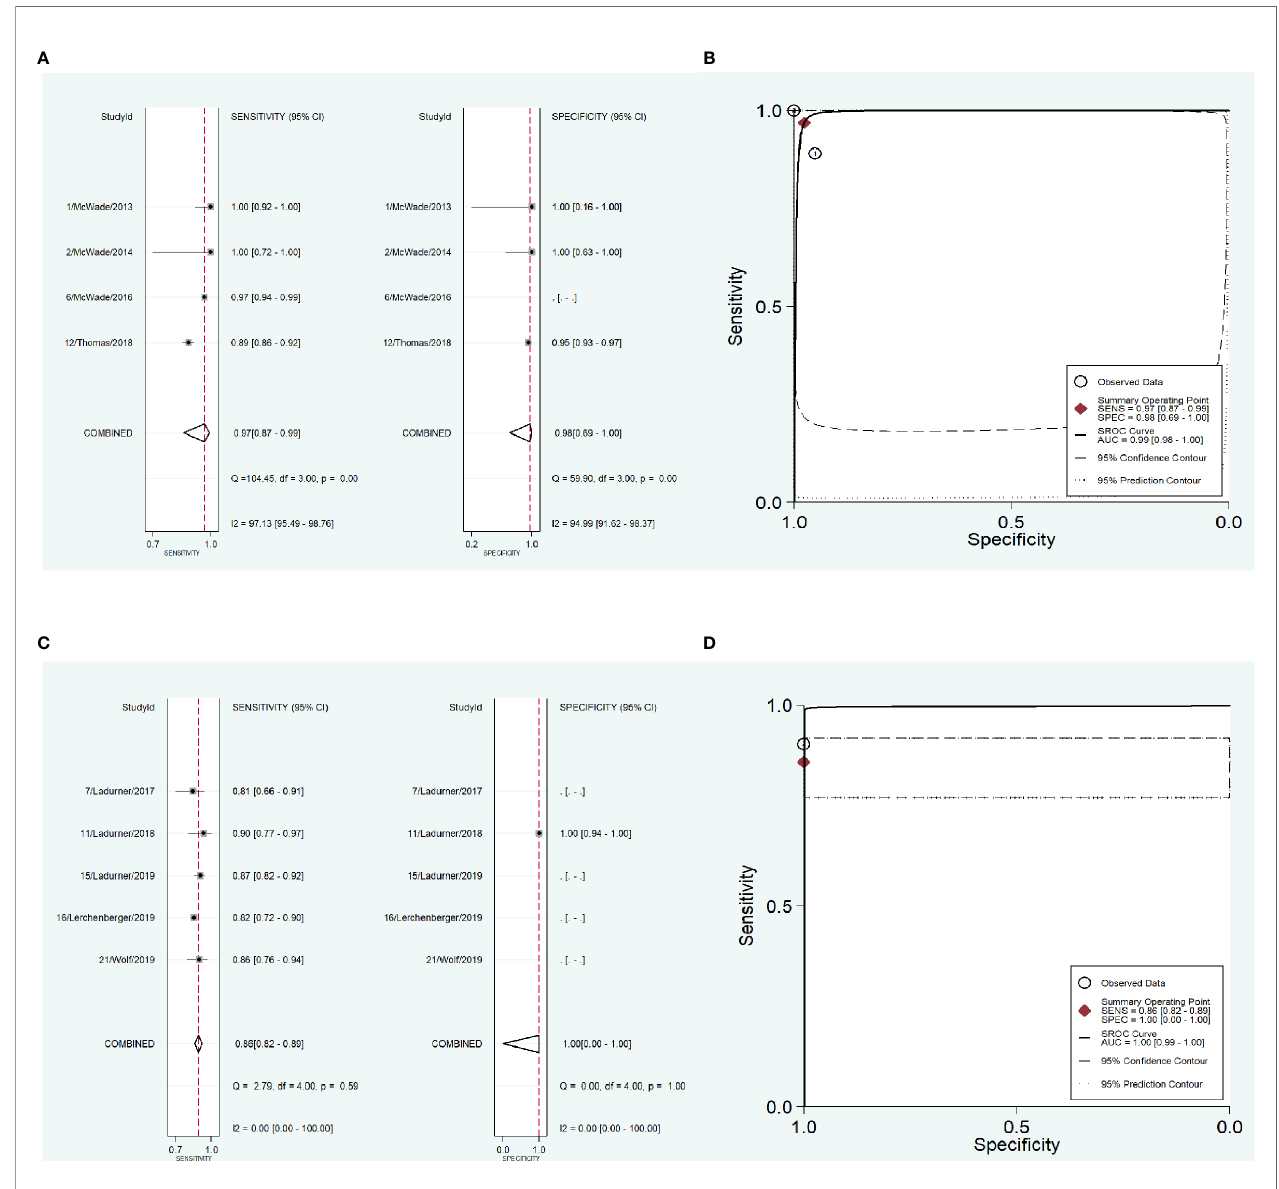
FIGURE 4 | The accuracy of near infrared auto fl uorescence in the subgroup analysis of the measurement instrument. (A) forest plot of the studies in the subgroup of fl uorescence spectroscopy system (spectrometer; S2000-FL; Ocean Optics, Dundelin, FL). (B) summary receiver operating characteristic (SROC) curve in the subgroup of fl uorescence spectroscopy system (spectrometer; S2000-FL; Ocean Optics, Dundelin, FL). (C) forest plot of the studies in the subgroup of near infrared system (Tricam SL II, Karl Storz GmbH &Co KG, Tuttlingen, Germany). (D) summary receiver operating characteristic (SROC) curve in the subgroup of near infrared system (Tricam SL II, Karl Storz GmbH &Co KG, Tuttlingen,